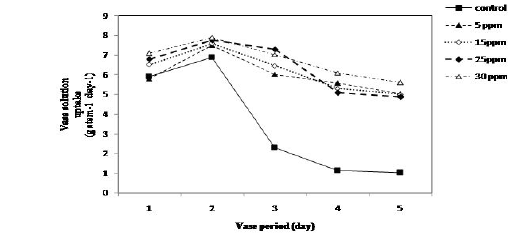
Fig 3. Effect of different concentration of SNP on vase solution